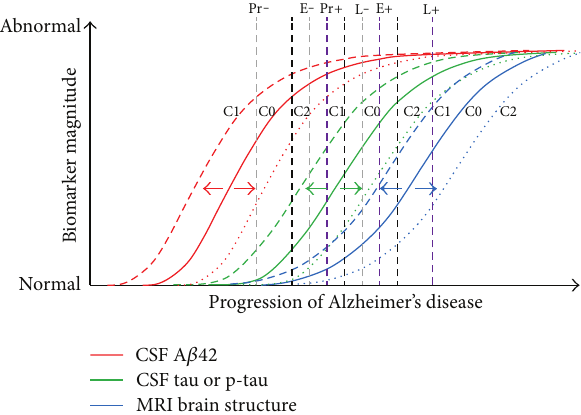
Figure 3: An hypothetical model showing the influence of genes, other diseases, and cognitive capacity on normal aging brain structure: C0 = CSF A 𝛽 42, Tau or p-tau with brain structure in individuals typically observed without genetic and innate factors; C1 = CSF A 𝛽 42, Tau or p-tau with brain structure in individuals typically observed with genetic risk loci (e.g., ApoE4) and/or together with comorbidity (e.g., cerebrovascular disease, cortical Lewy bodies, and frontal damage); C2 = CSF A 𝛽 42, Tau, or p- tau with brain structure in individuals typically observed with high cognitive reserve or protective genetic loci (e.g., ApoE2); Pr − , Pr+, E − , E+, L − , and L+ = shifts early and late during preclinical, early, and late mild cognitive impairment stages. This modify illustration is adapted from figures in [91,